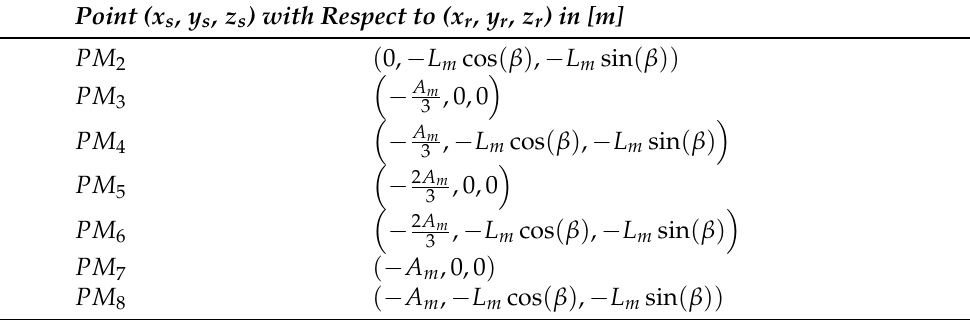
Table 2. Location of PM 1 to PM 8 for the